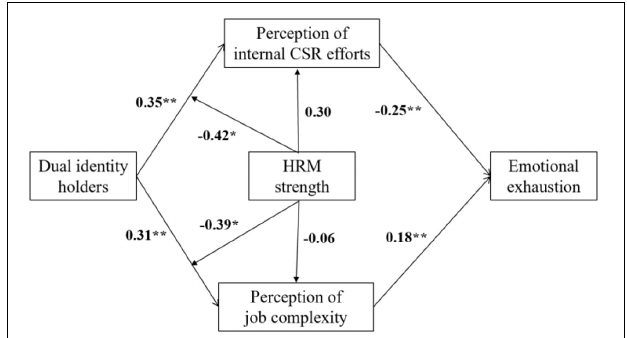
FIGURE 2 | Results testing all hypotheses.